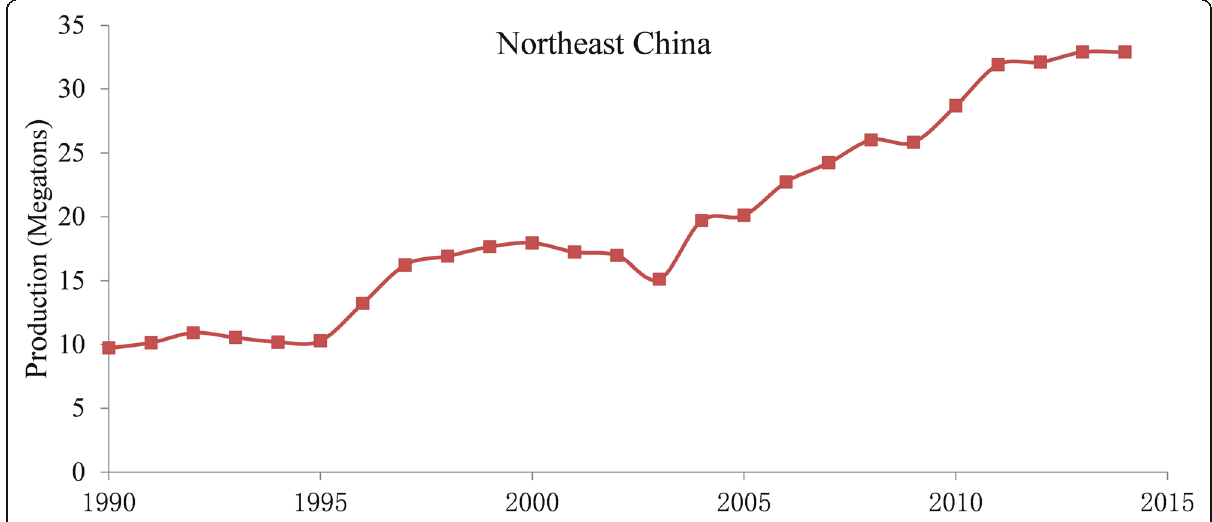
Fig. 2 The annual production of japonica rice in northeast China from 1990 to